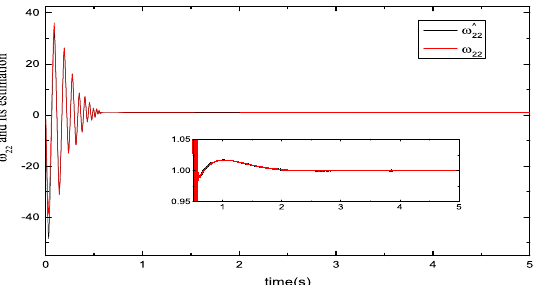
Figure 7. Estimated performance evaluation curves of four motor velocities: velocity ω 2 and its estimated value curve.